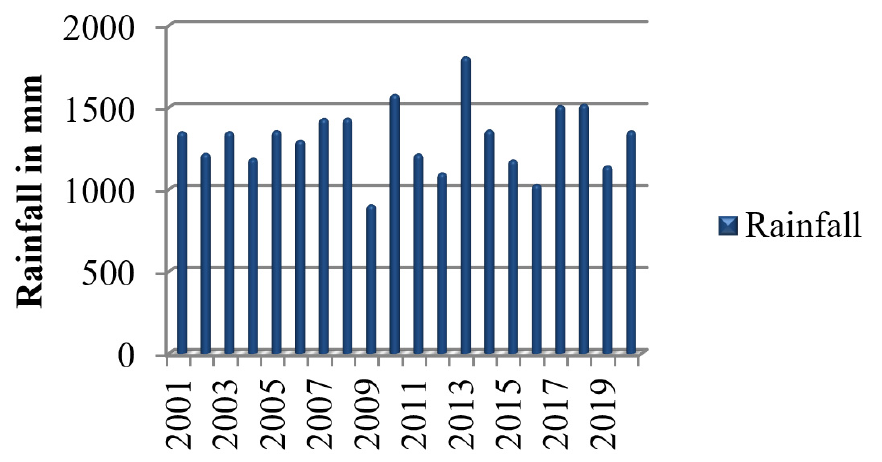
Figure 2. Rainfall (in mm) in the Sirmaur district.